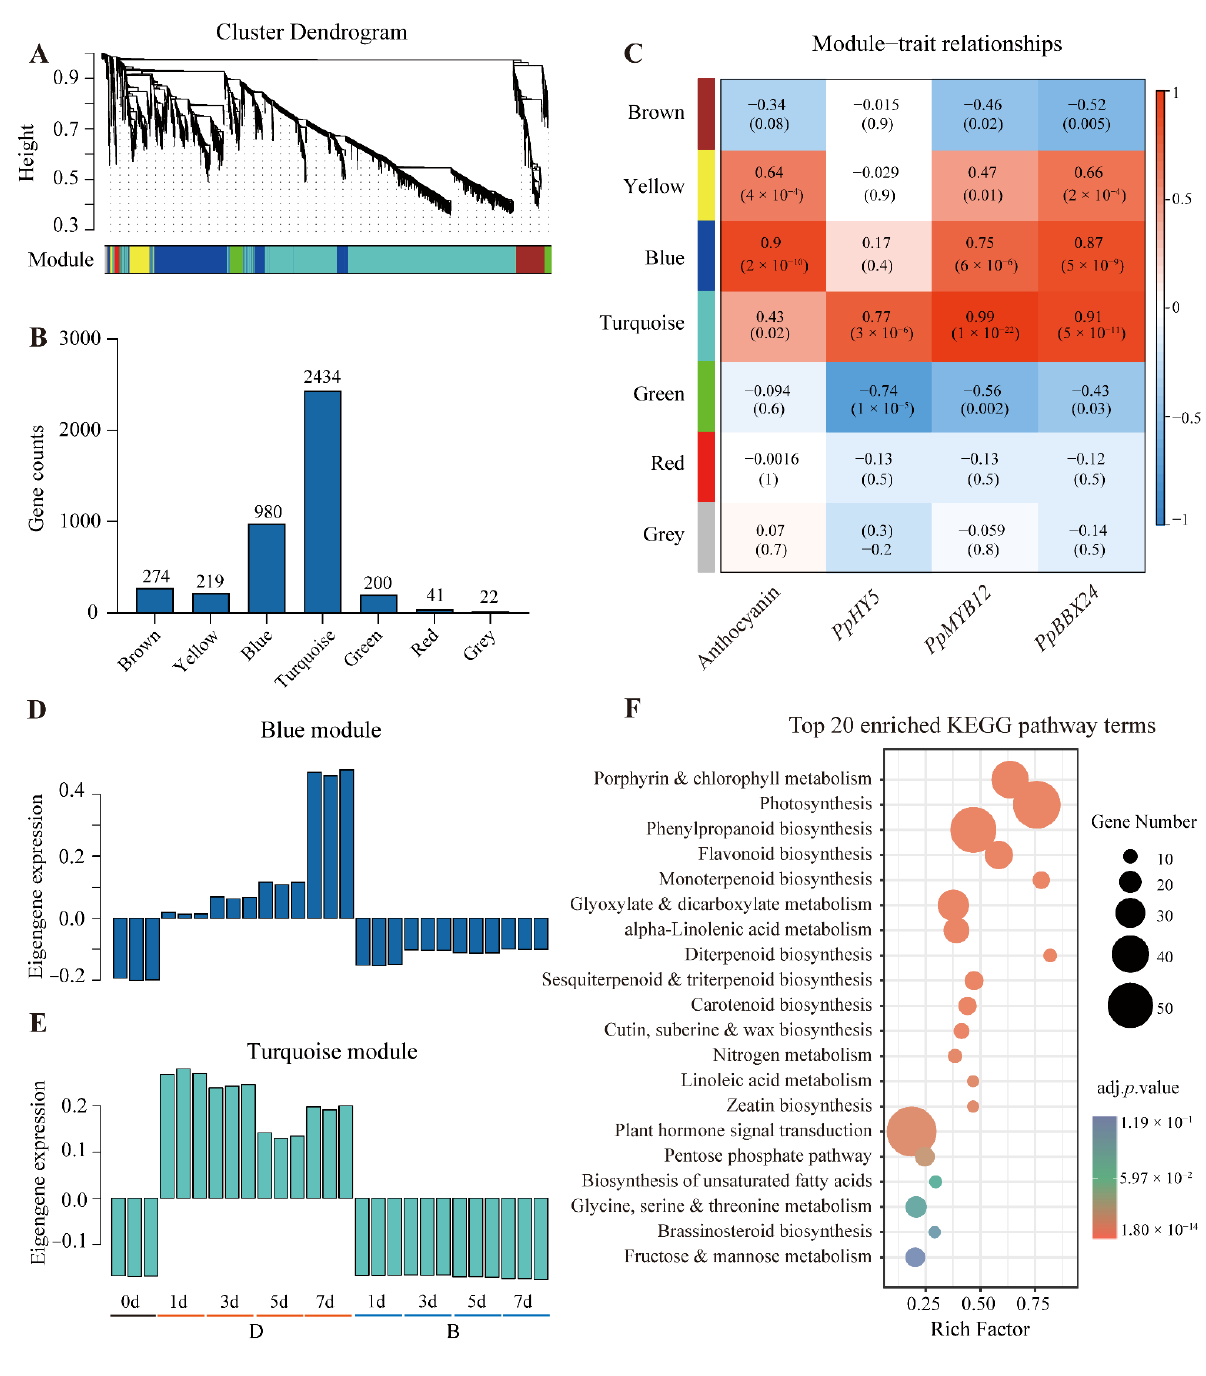
Figure 5. WGCNA and KEGG enrichment analysis. ( A ) Module construction of WGCNA. ( B ) Genes counts in each module. ( C ) Heatmap showing module–trait relationships. The numbers in each grid are Pearson correlation coefficient and significant p value in brackets. ( D ) Eigengene expression in “Blue” module. ( E ) Eigengene expression in “Turquoise” module. ( F ) Scatter plot showing top 20 enriched KEGG pathways in “Blue” and “Turquoise” modules.